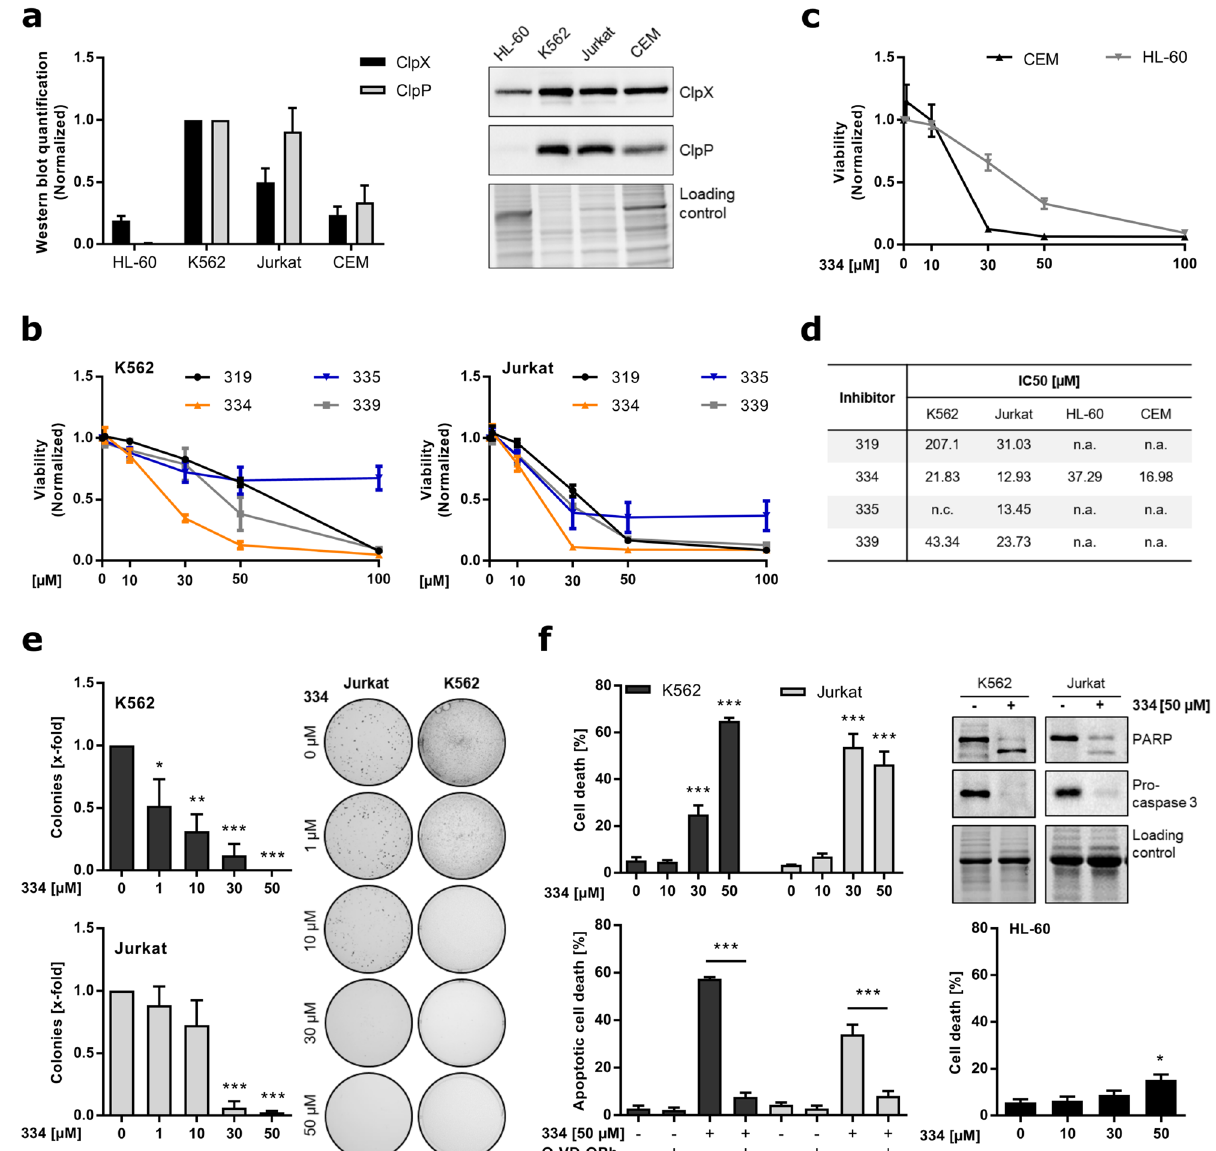
Figure 2. 334 treatment impairs viability and colony formation of various leukemia cell lines. ( a ) ClpX and ClpP protein is expressed in various leukemia cell lines. Western blot analysis was performed for ClpX and ClpP in HL-60, K562, Jurkat, and CEM cells. The quantification of ClpX and ClpP protein expression was normalized to K562 and the respective protein load (n = 3). ( b ) 334 has strongest impact on cell viability of K562 and Jurkat cells. Cell viability of K562 and Jurkat cells upon 334 treatment (72 h) was normalized to the DMSO treated control (n = 3). ( c ) 334 treatment decreases cell viability of various leukemia cell lines. Cell viability of HL-60 and CEM cells upon 334 treatment for 72 h was normalized to the DMSO treated control. ( d ) IC 50 determination of various ClpXP inhibitors. Table shows IC 50 values calculated by nonlinear regression analysis. Missing data was not assessed (n.a.) or not calculated (n.c.) due to an insufficient inhibitory effect (n = 3). ( e ) 334 impairs clonogenic growth of K562 and Jurkat cells. Colony count of K562 and Jurkat cells normalized to untreated control cells is shown (left panels). Representative images of colonies formed by Jurkat and K562 cells pretreated with 334 for 24 h and grown in the absence of 334 for further 7 days are shown (right panel) (* P < 0.05, ** P < 0.01, *** P < 0.001, One-way ANOVA, Tukey’s Multiple Comparison Test, n = 3). ( f ) 334 induces apoptotic cell death in K562 and Jurkat cells. Cell death upon 334 treatment (48 h) was assessed by flow cytometry using Nicoletti assay (upper left panel). Western blot analysis of PARP and procaspase-3 protein expression together with the respective whole protein loading controls are shown for K562 and Jurkat cells treated with 334 (50 µM, 24 h) (n = 3). The apoptotic cell death was assessed for cells treated with 334 (50 µM, 48 h), the pan-caspase inhibitor Q-VD-OPh (20 µM, 30 min) or a combination of Q-VD-OPh pretreatment prior to 334 exposure (50 µM, 48 h) (lower left panel). Cell death of HL-60 cells treated with 334 for 48 h is shown (lower right panel) (* P < 0.05, *** P < 0.001, One-way ANOVA, Tukey’s Multiple Comparison Test, n = 3). For ( a ) and ( f ) full length blots are presented in Supplementary Fig. S8 online. See also Supplementary Figs. S2 and S3